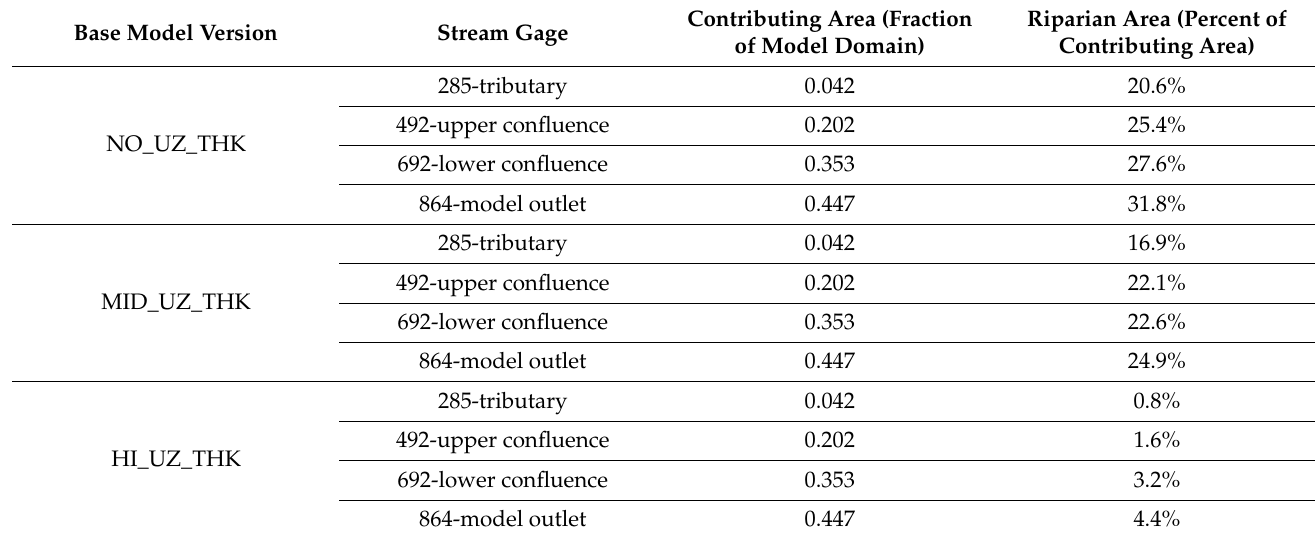
Table 4. Percent of the contributing area above each stream gage (Figure 2) that is classified as riparian